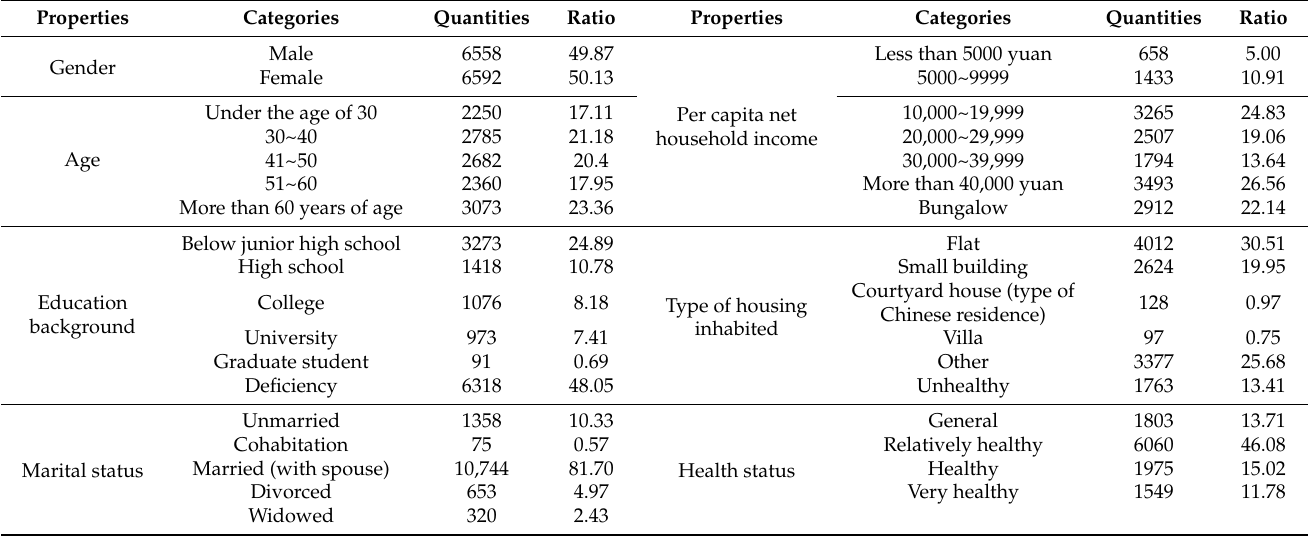
Table 2. Sample socio-economic attributes